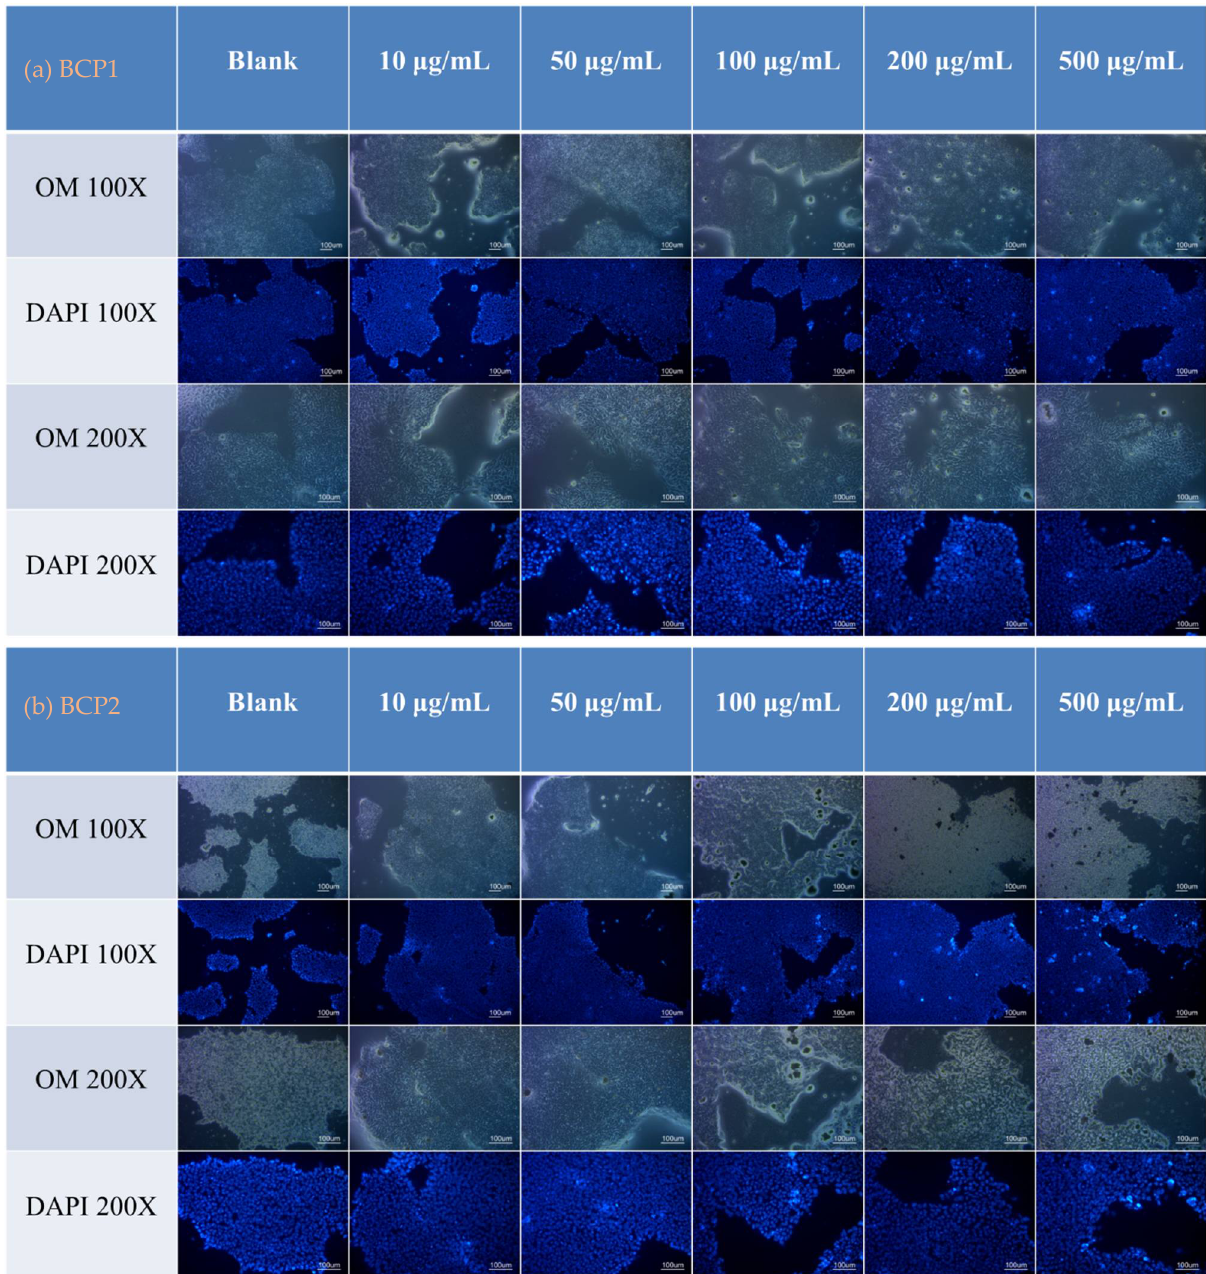
Figure 3. Optical microscopy imaging (OM) and nuclear (DAPI) staining of iPSCs incubated with various concentrations of ( a ) BCP1 and ( b ) BCP2 on the 1st, 3rd, and 5th day.